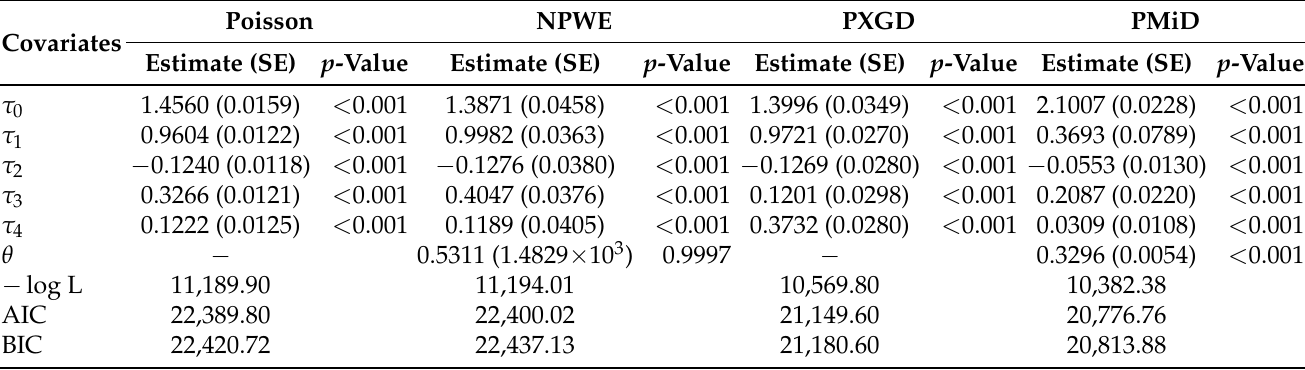
Table 8. Regression results on the length of the hospital stay dataset (Standard errors in brackets). Poisson NPWE PXGD PMiD Covariates Estimate (SE) p -Value Estimate (SE) p -Value Estimate (SE) p -Value Estimate (SE) p